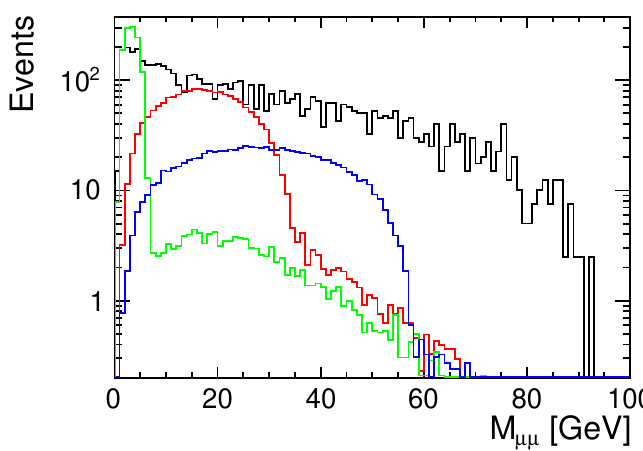
Figure 4 . Distribution of the lepton pair invariant mass, M (cid:22)(cid:22) , for BP1 (red histogram), BP2 (green) and BP7 (blue) signal scenarios, compared with expected Standard Model background (black histogram), after (cid:12)nal event selection cuts (see text for details). Samples simulated for CLIC running at 380 GeV are normalised to 1 ab (cid:0) 1 .